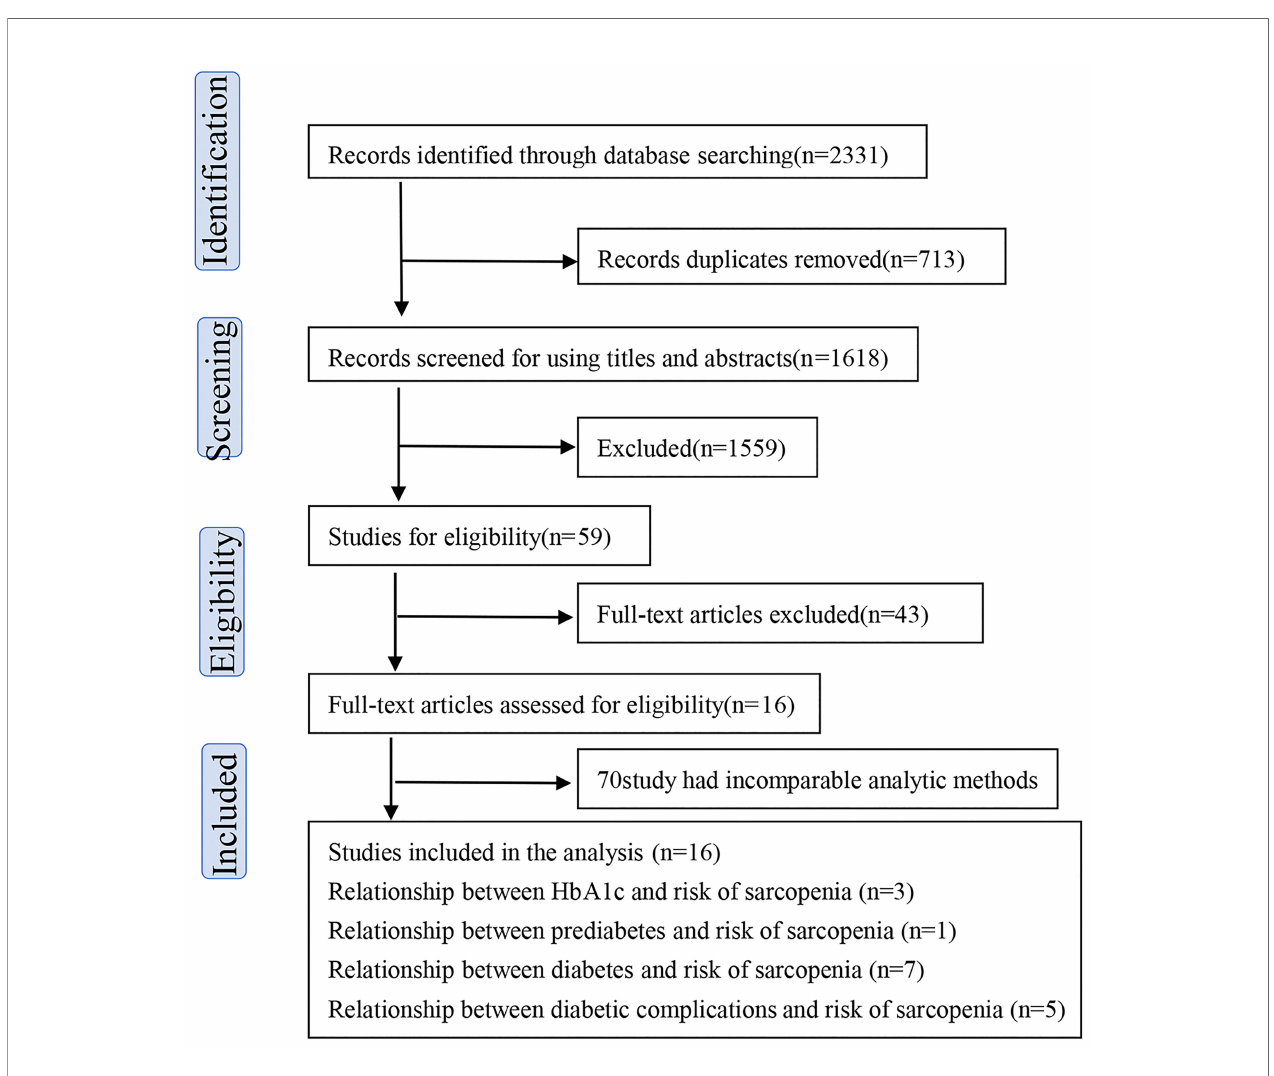
FIGURE 1 | PRISMA (Preferred Reporting Items for Systematic Reviews and Meta-Analyses)